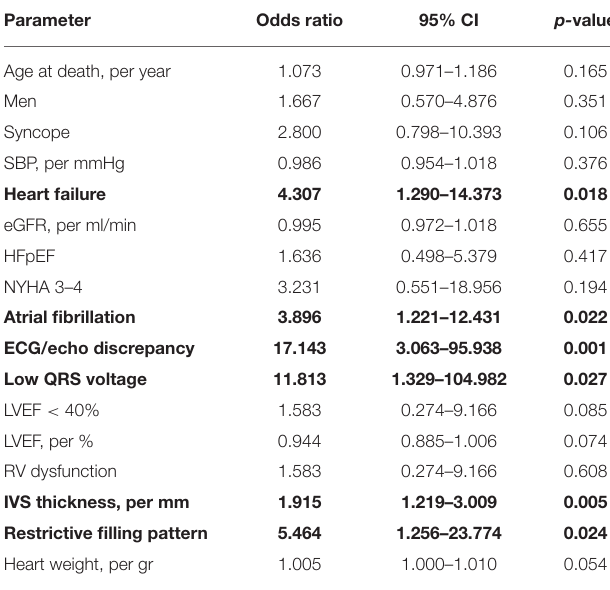
restrictive filling pattern, 56% thickened IAS, 38% thickened AV valves, 38% granular sparkling and 25% pericardial effusion. At least 3 echocardiographic CA red flags were present at the last echocardiography for 31% of the patients. No gender difference was found in their prevalence. Although showing a similar overall frequency of atrial amyloidosis, patients with thickened IAS at echocardiography had a higher frequency of diffuse amyloid infiltration in the atria compared to those without thickened IAS (67 vs. 14%, p = 0.036) ( Figure 1 ). There were no morphological differences between patients with and